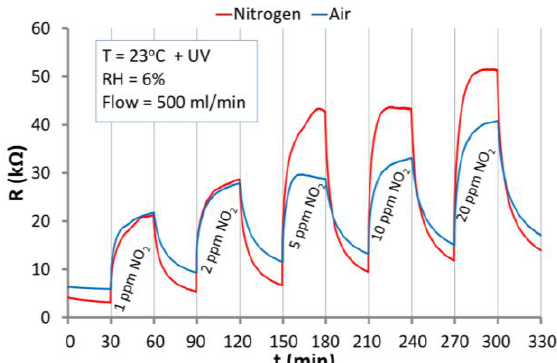
Figure 9. The response of the ZnO nanostructures to the effect of NO 2 and ultraviolet (UV) irradiation in atmospheres of air and nitrogen at RT.